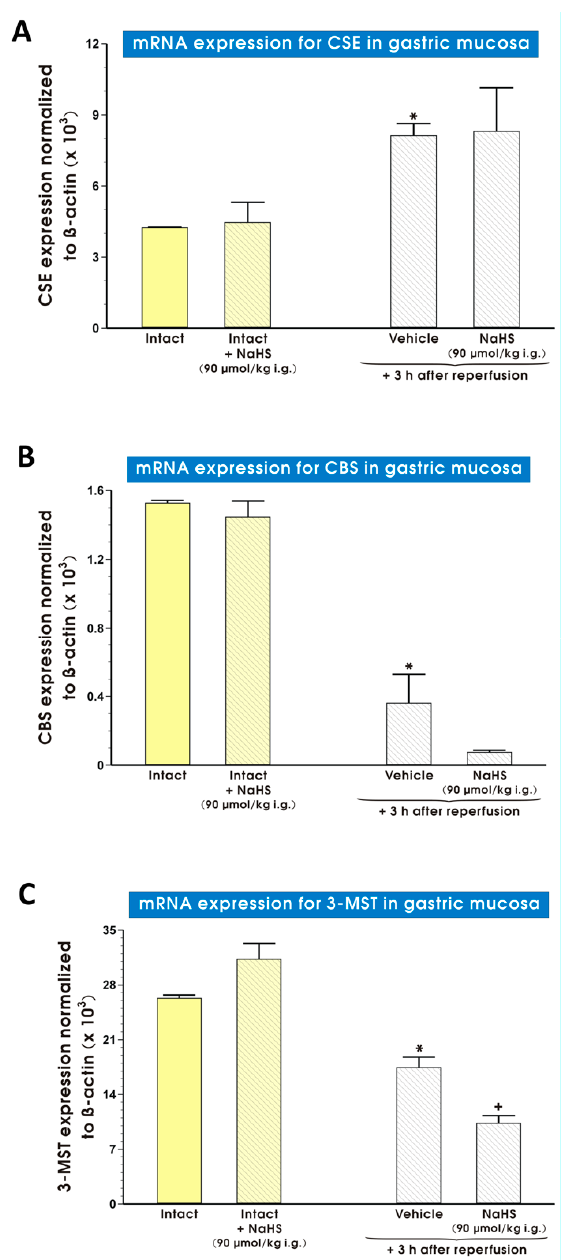
Figure 6. Expression of mRNA for CSE ( A ), CBS ( B ) and 3-MST ( C ) in gastric mucosa of rats pretreated with vehicle (saline) or NaHS (90 µ mol/kg i.g.) with or without exposure to I followed by 3 h of R. Results are mean ± S.E.M of 4–5 rats per each experimental group. An asterisk indicates a significant change as compared with intact rats ( p < 0.05). A cross indicates a significant difference as compared with vehicle pretreated group ( p < 0.05).